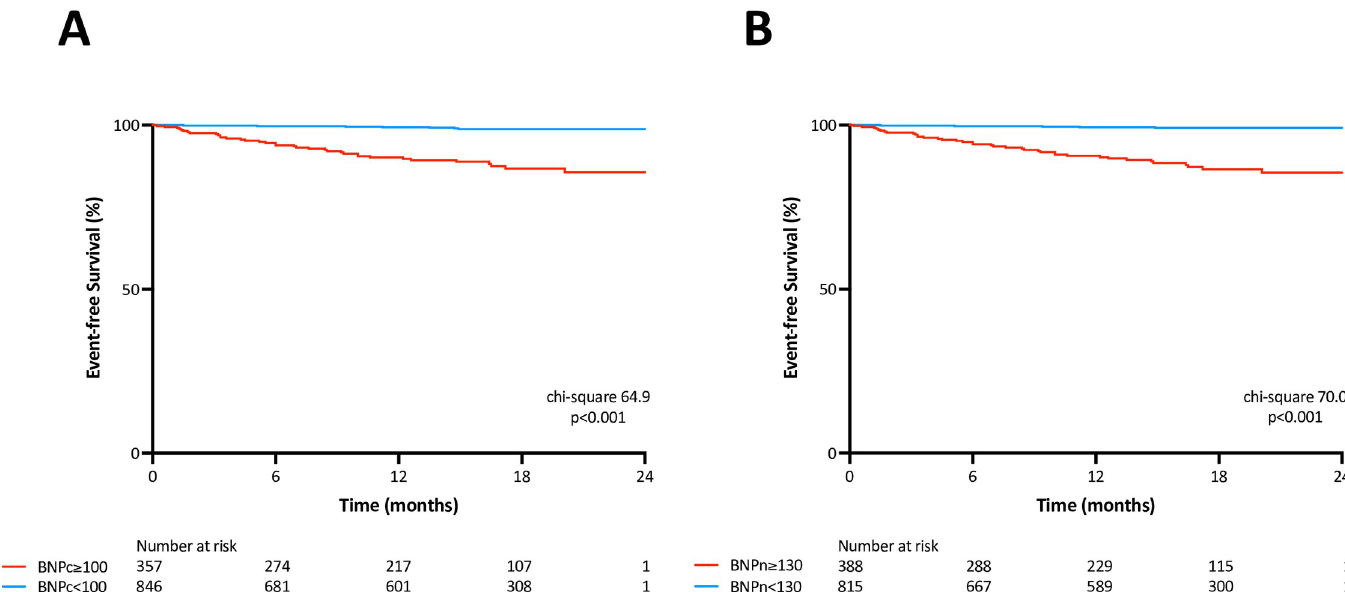
Fig 4. Kaplan-Meier survival analysis for cardiac events. A: Brain natriuretic peptide by the conventional method (BNPc), B: Brain natriuretic peptide by the novel method (BNPn). Patients were classified into two groups according to cut-off values. Note that different cut-off values were employed, 100 ng/L for BNPc and 130 ng/L for